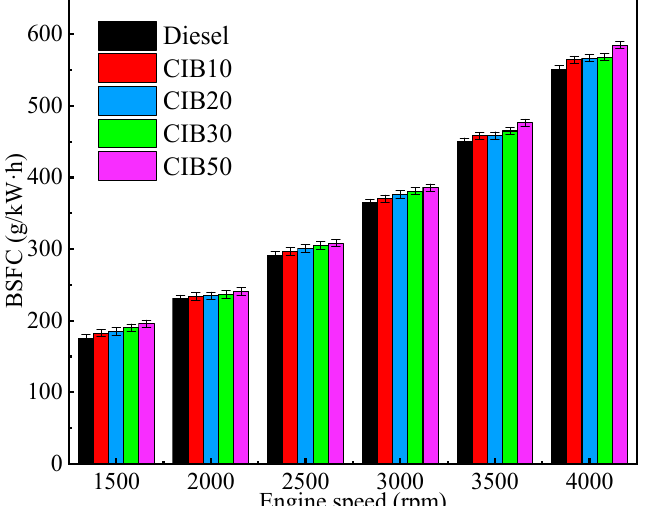
Figure 16. BSFC comparison of CIB biodiesel and diesel at different engine speeds [189].